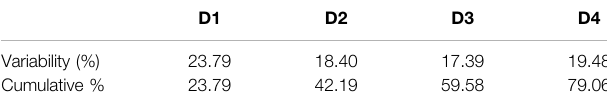
TABLE 8 | Percentage of variance and cumulative variance after Varimax rotation.